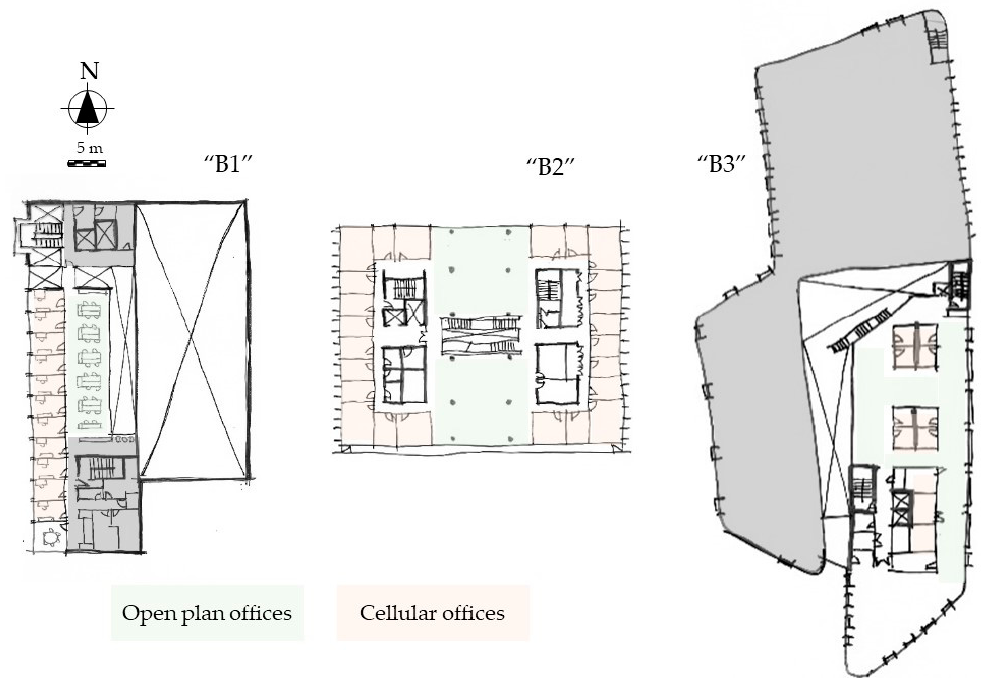
Figure 1. Floor plans of the open (green) and cellular (orange) office spaces in B1 (left), B2 (middle) and B3 (right) buildings at the University of Southampton Bolderwood (B1 and B2) and Highfield (B3) campuses.